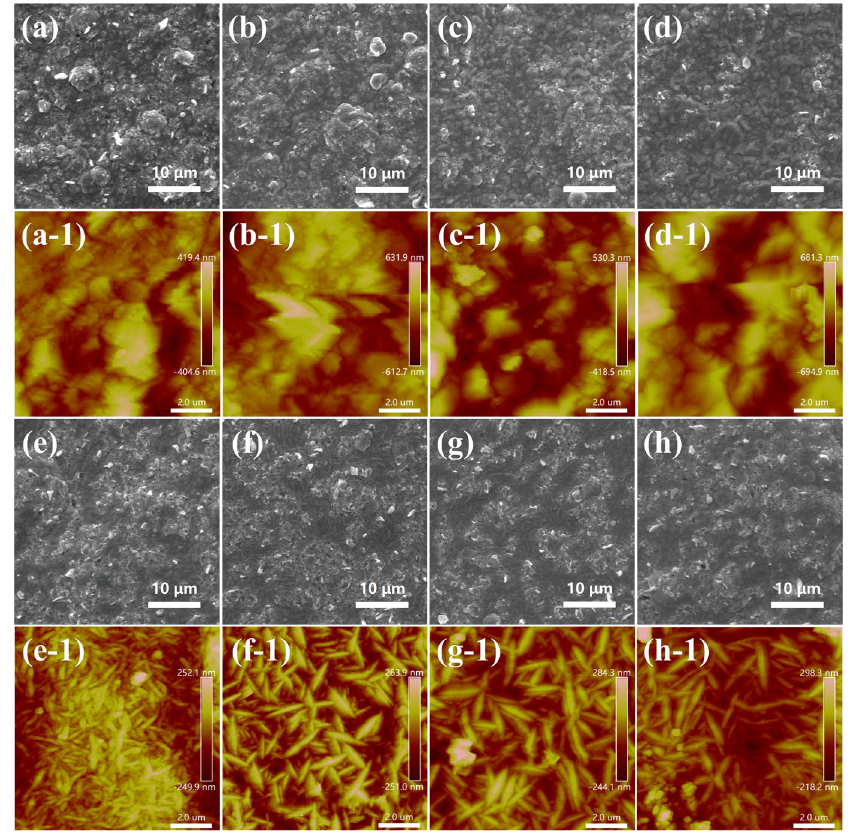
Figure 5. SEM characterization. ( a – d ) surface morphology of Ni/SDS-SiC coatings at current densities of 2.0, 4.0, 6.0 and 8.0 A dm − 2 ; ( e – h ) surface morphology of Ni/binary-SiC coatings at current densities of 2.0, 4.0, 6.0 and 8.0 A dm − 2 . AFM characterization. ( a-1 – d-1 ) AFM images of Ni/SDS-SiC coatings at current densities of 2.0, 4.0, 6.0 and 8.0 A dm − 2 ; ( e-1 – h-1 ) AFM images of Ni/binary-SiC coatings at current densities of 2.0, 4.0, 6.0 and 8.0 A dm − 2